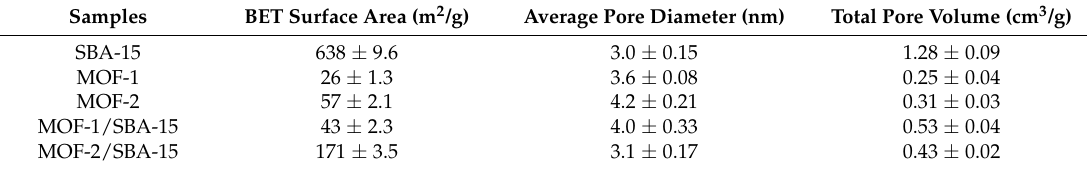
Figure 5. ( A ) Nitrogen adsorption–desorption isotherms of the samples; ( B ) BJH pore size distribution of the samples. Table 2. Textural properties of the samples from nitrogen adsorption–desorption